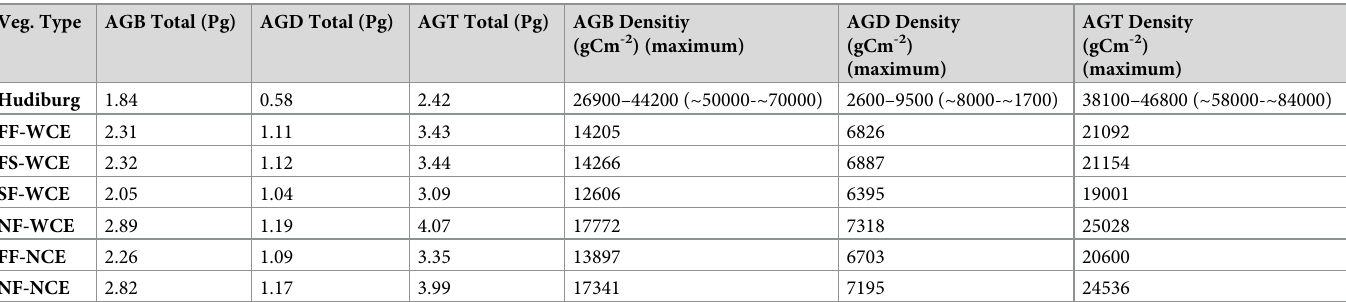
Table 3. Carbon values for Hudiburg and MC2